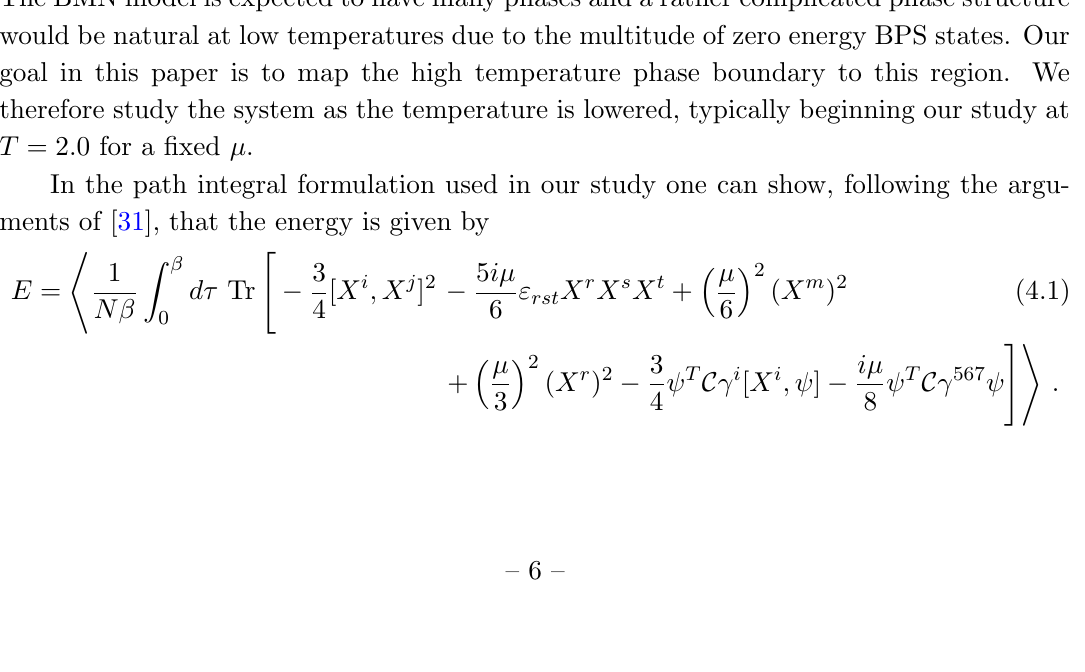
, r = 0, r = 1 , 1 f b 3 12 a